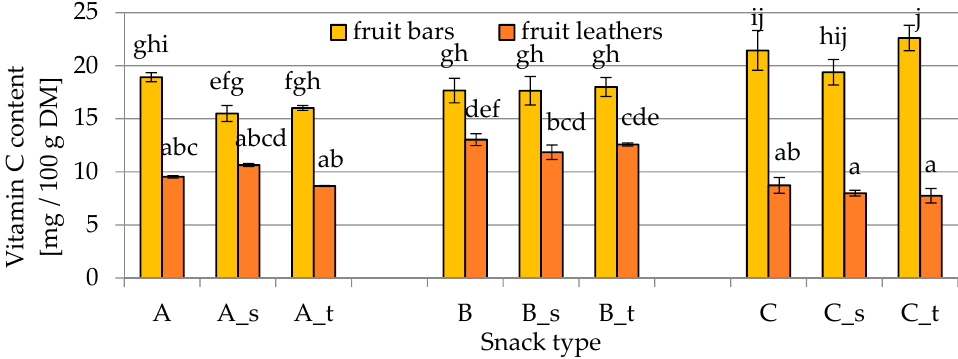
Figure 1. Vitamin C content in fruit bars and leathers (A, B, C—different composition; s—sucrose addition; t—trehalose addition; DM—dry matter) obtained using liquid chromatography, as described in Section 4.2.1. Different letters above the columns indicate significant differences ( α = 0.05) between all considered samples.